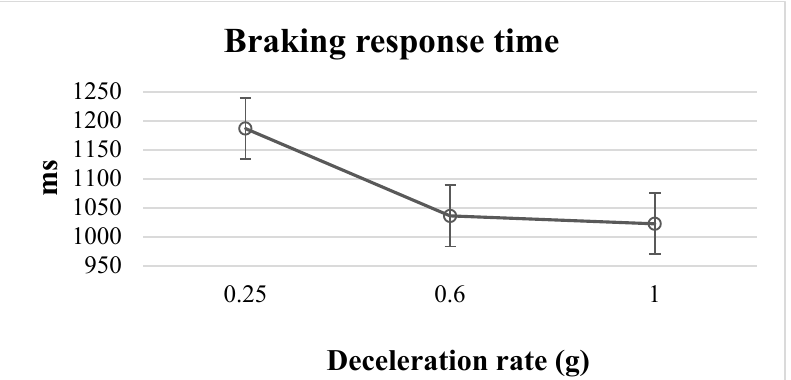
Figure 4. Braking response time for three deceleration rates in the 50 km/h driving environment.